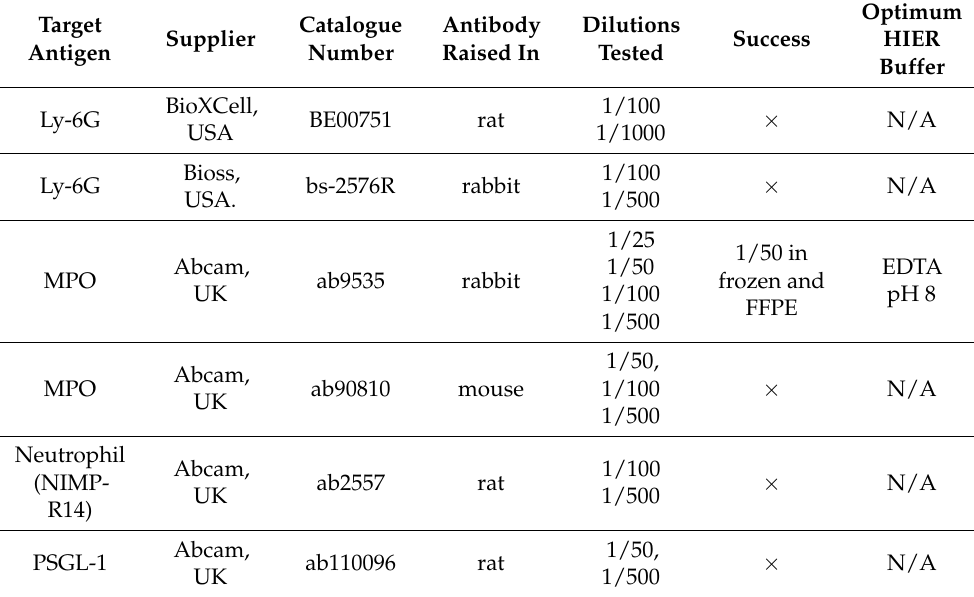
Table 3. Neutrophil-specific antibodies tested in pig tissue.